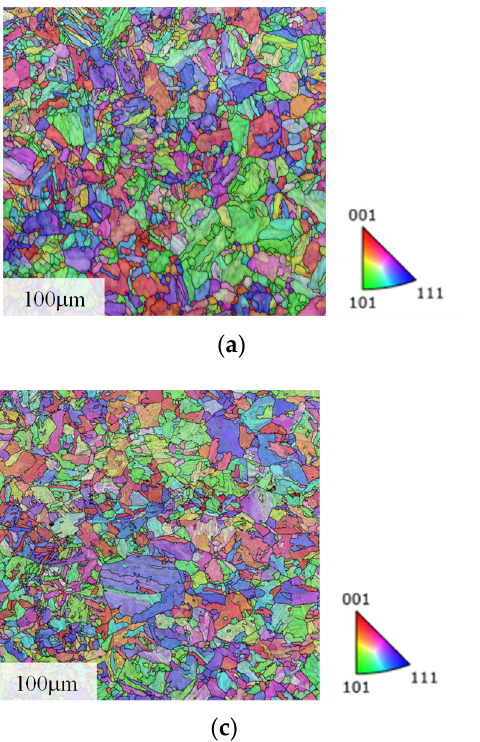
Figure 18. Stress result diagram of crack tip region under 43 kN load ( a ) − 20 °C; ( b ) − 100 °C.